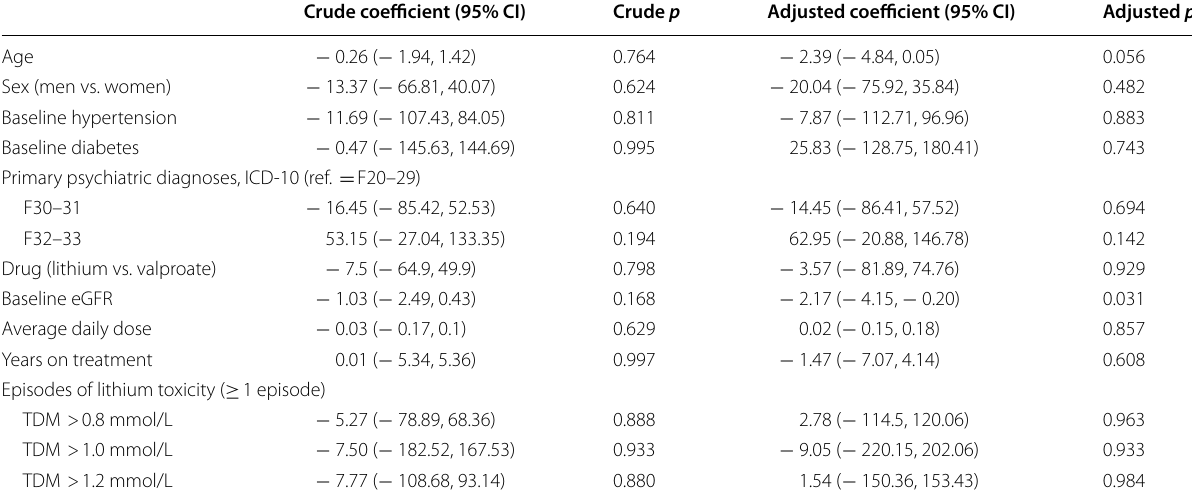
Table 2 Linear regression predicting yearly eGFR change Crude coefficient (95%